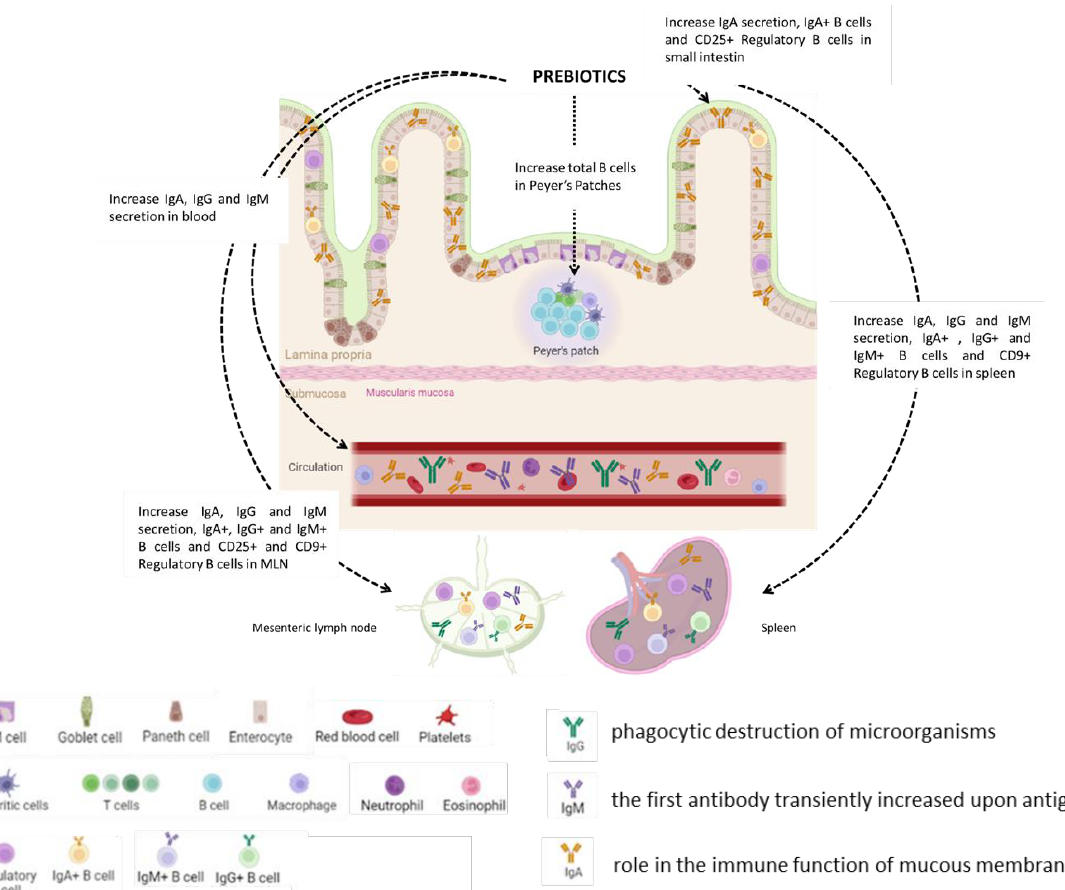
Figure 1. Effects of prebiotics on the immune B response in hosts. Prebiotics boost the immune B response in local and systemic manners. Prebiotcs increase IgA secretion, IgA + B cell number, and regulatory B cells in small intestine. Prebiotics induce a higher percentage of total B cell in Peyer’s Patches and increase IgA, IgG, and IgM secretion in the serum. Prebiotics up-regulate immunoglobulin secretion and IgA + , IGM + , and IgG + B cells also in mesenteric lymph nodes. Futhermore, prebiotics modulate systemic B response with an increase in Ig secretion and IgA + , IGM + , and IgG + B cells in the spleen.